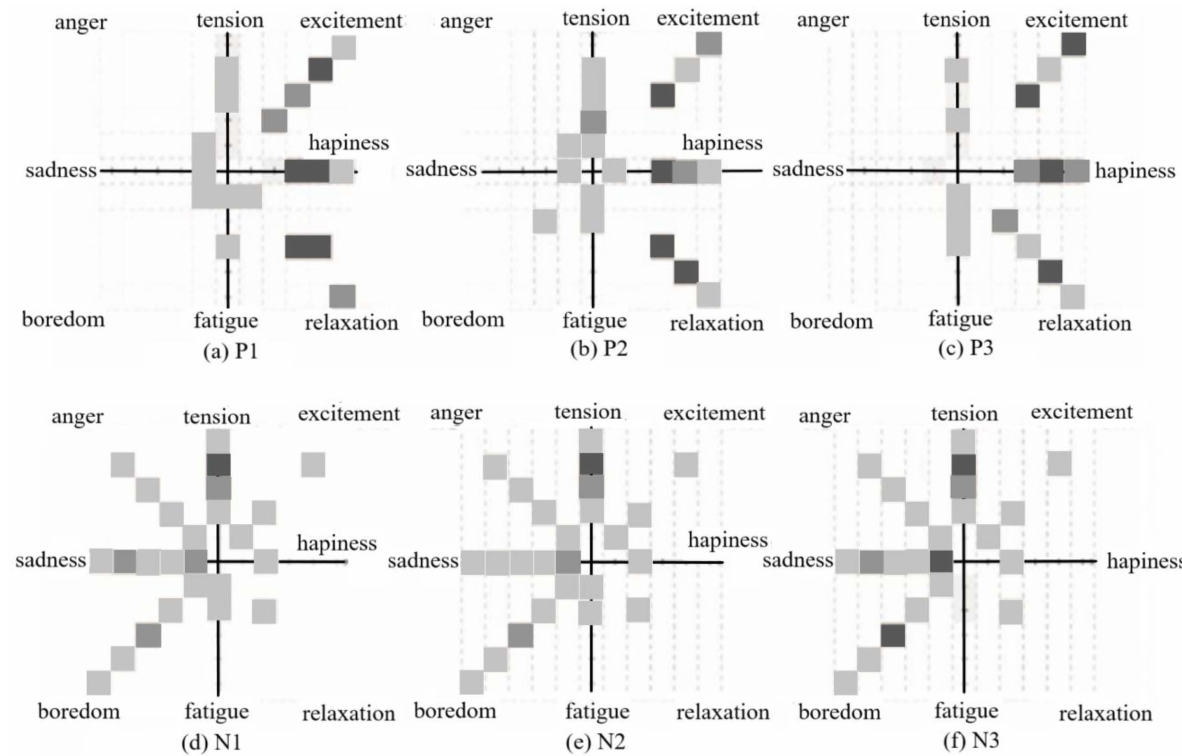
Figure 6. Emotional rate of six game events.